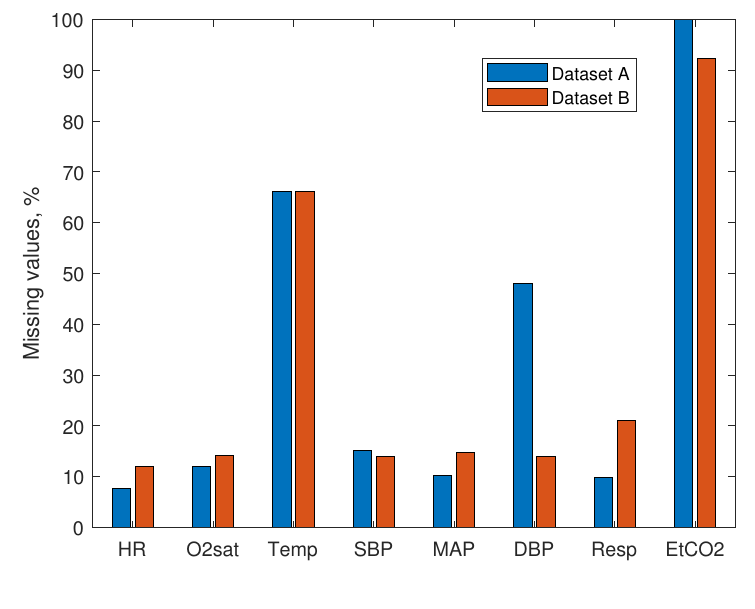
Figure 1. Missing vital values in the data.